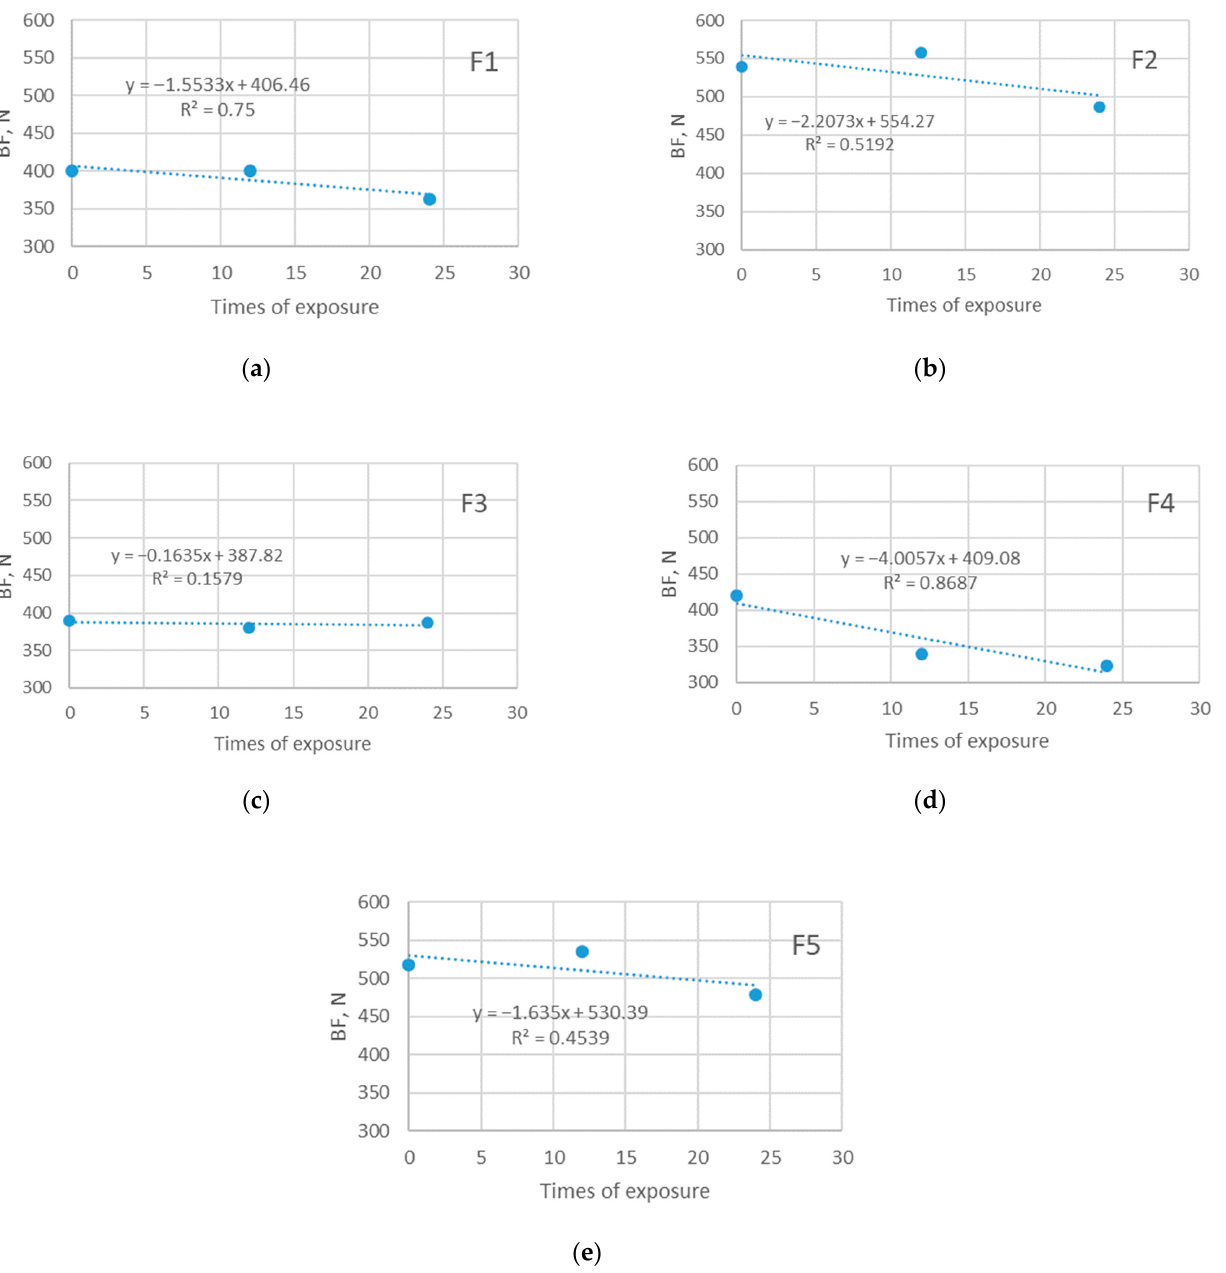
Figure 11. Bursting force of five investigated materials exposed in shade: ( a ) F1; ( b ) F2; ( c ) F3; ( d ) F4; ( e ) F5.